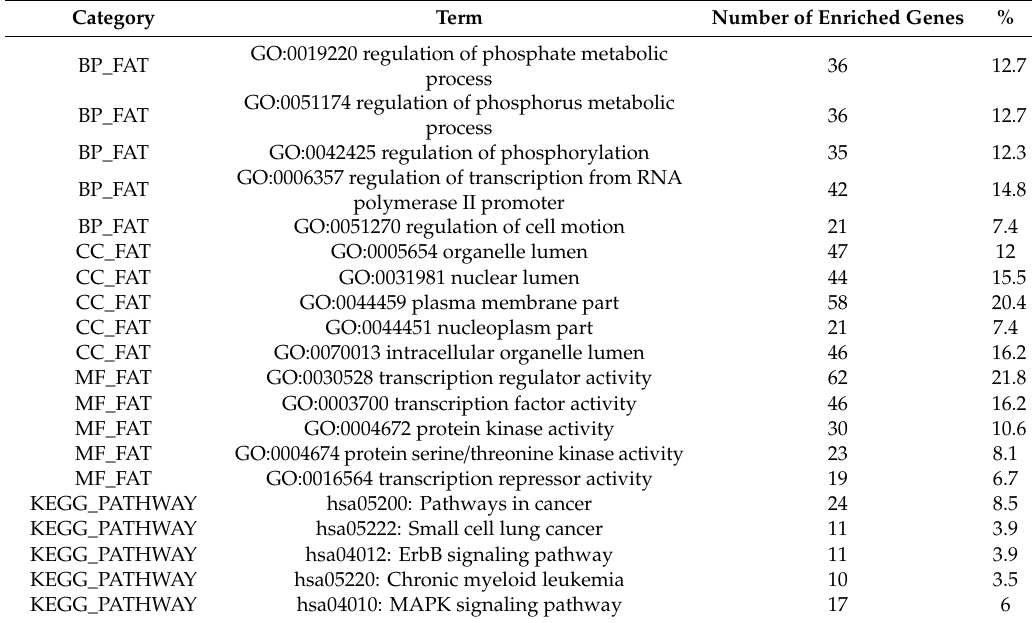
Table 4. GO functional and pathway enrichment analyses of DEGs in breast